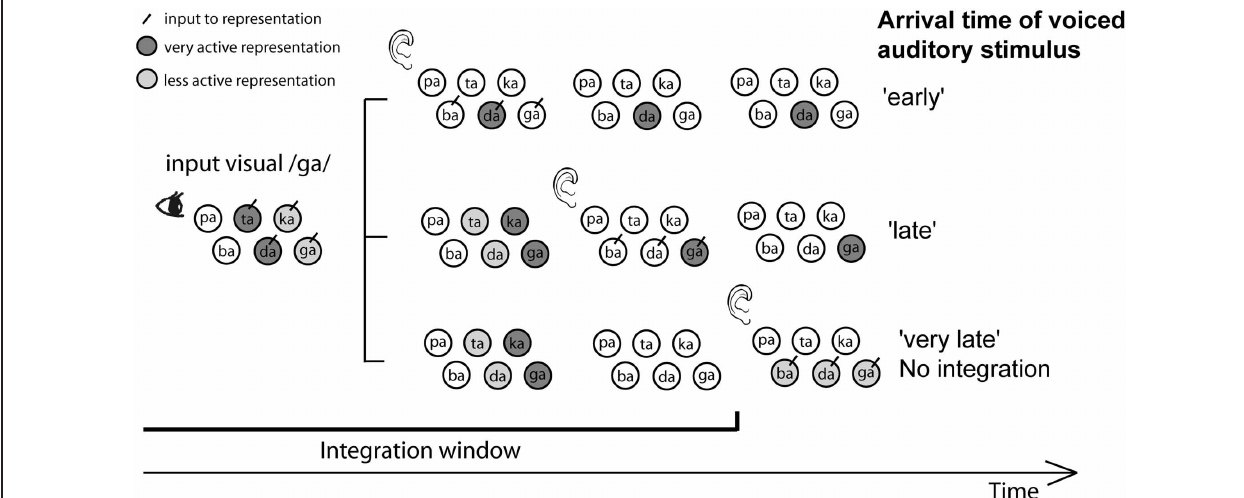
information activates representations of syllables (represented along the vertical axis) is important for winning the decision making process. When auditory syllables arrive early, and therefore resemble more closely natural audio-visual onset differences for /da/, /da/ is more active than /ga/, and has the highest chance to win the decision making process. In this example, the visual cues can not distinguish between the different coronal and dorsal possibilities, and the auditory cues cannot distinguish the POA at all, so the arrival of the auditory information (early vs. late) facilitates this decision; early onset will activate the coronal /da/ and late onset will activate the dorsal /ga/